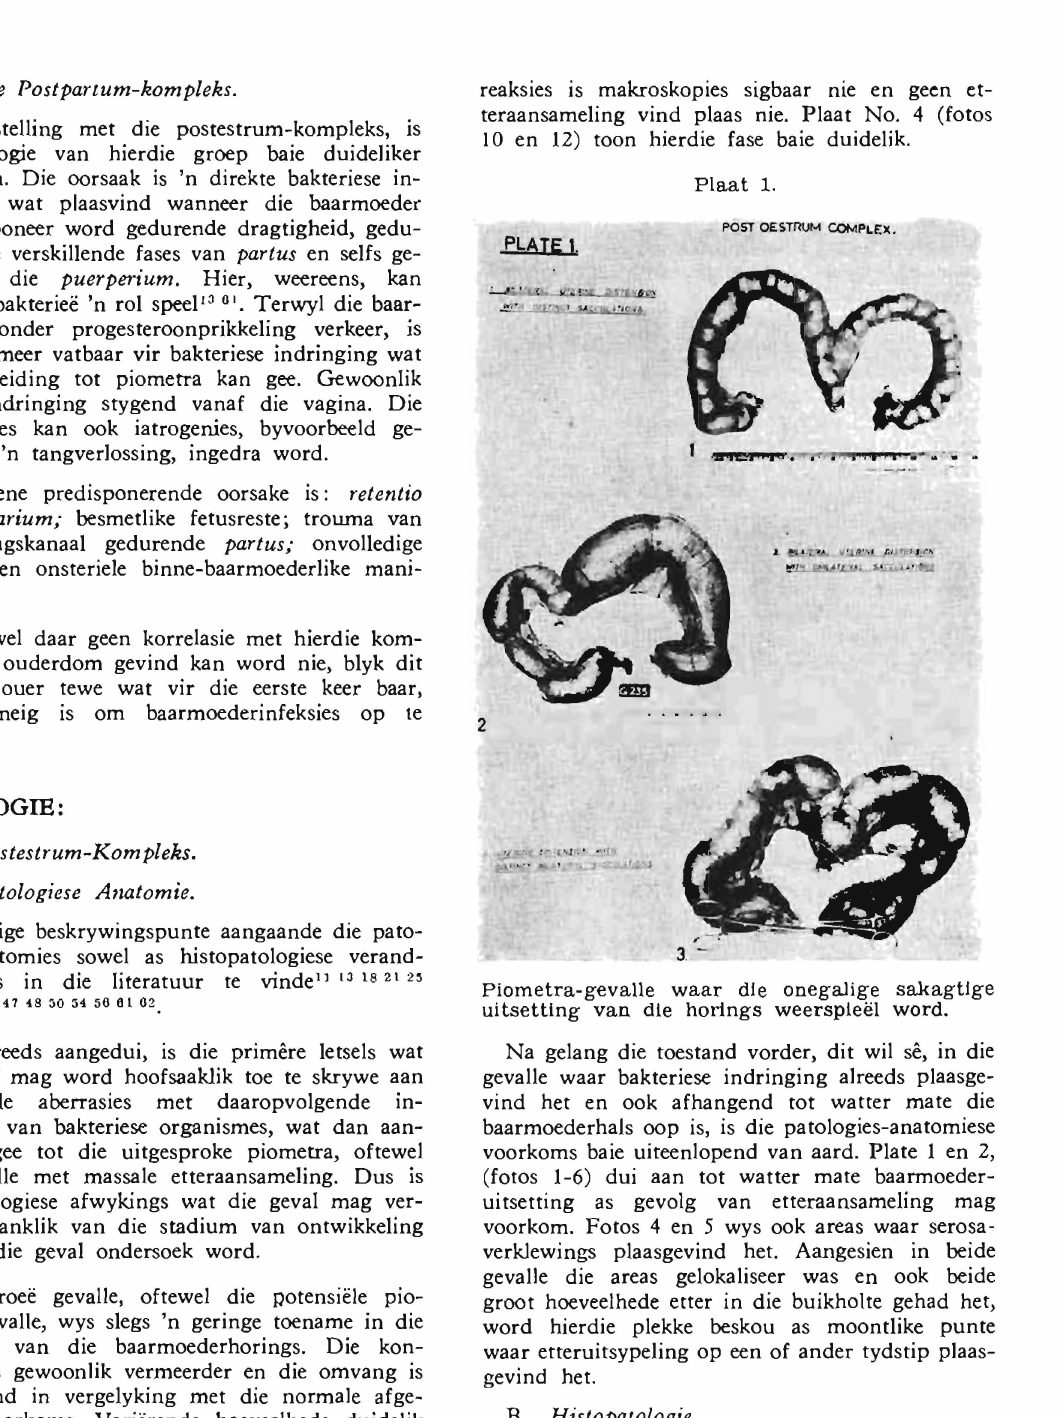
waarneembare siste Ie verspreid dwarsdeur die endometrium. Hierdie siste mag soms een tot meer sentimeters in deursnee wees. Geen inflammatoriese